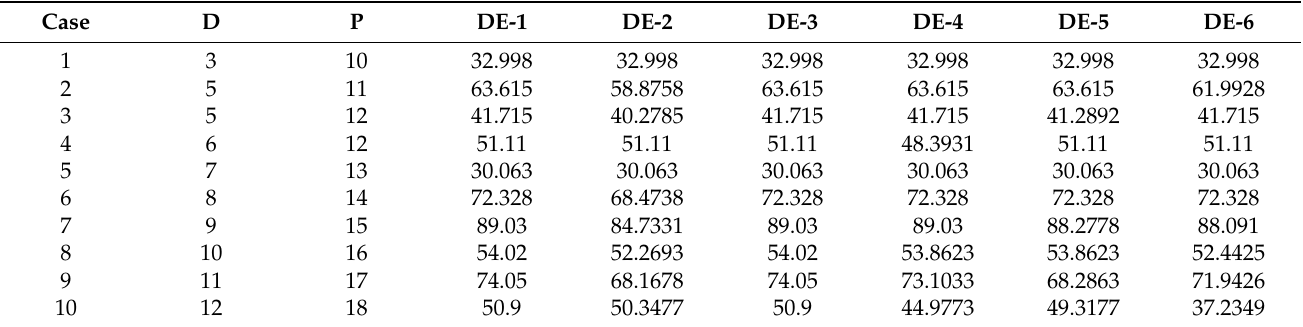
Table 18. Fitness function values for six discrete DE algorithms with population size NP = 50; r D = r P = 0.1.